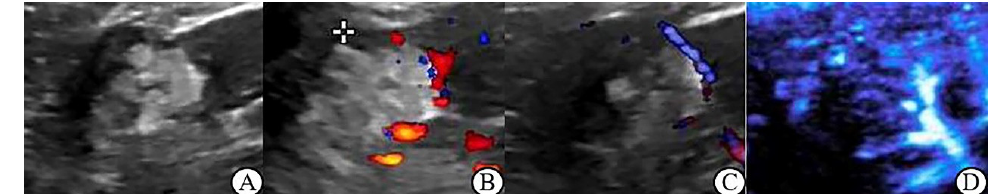
Figure 1. Angiomyolipoma (largest diameter: 2.9 cm) ( A ): Grayscale ultrasound: the mass with clear boundary, hyperechoic, and the internal echogenicity was heterogeneous; ( B ): CDFI: 2 dotted blood flow signal was observed in the lesion, Adler Grade 1; ( C ): PDI: Linear blood flow signal was seen around the lesion, Adler Grade 1; ( D ): MFI: 2 dotted blood flow signal was observed in the lesion, 2 linear blood flow signal was observed around the lesion, Adler Grade 2, there is no annulus blood flow.